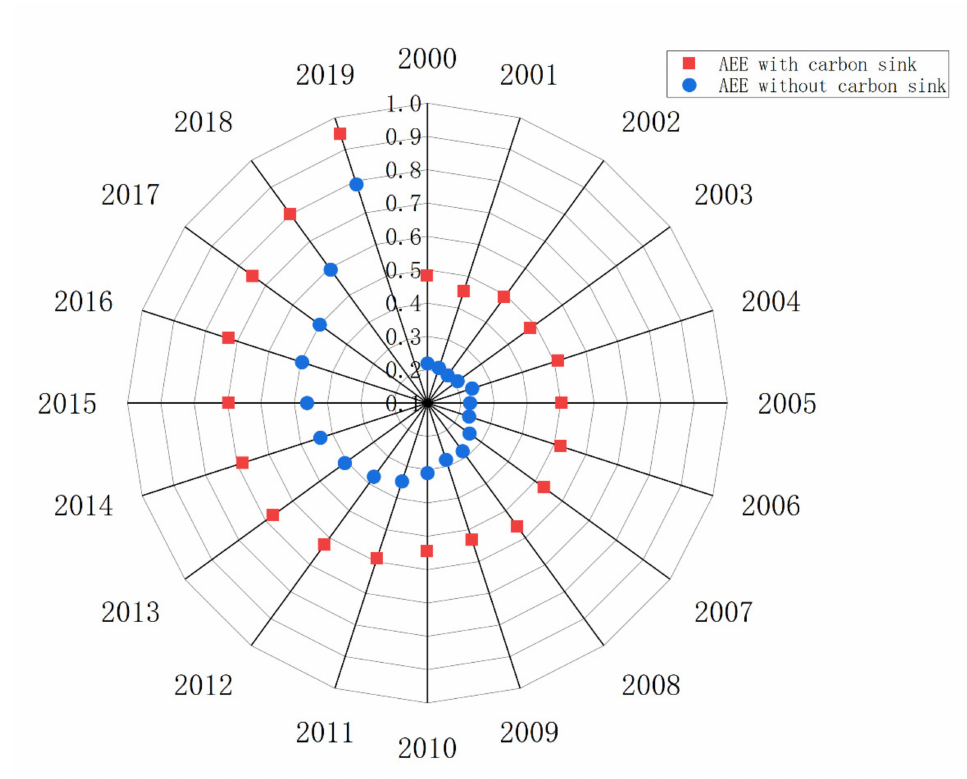
Figure 1. China’s AEE with and without agricultural carbon sinks for the period 2000–2019. Table 3. AEE ranking of 31 provinces in China with and without agricultural carbon